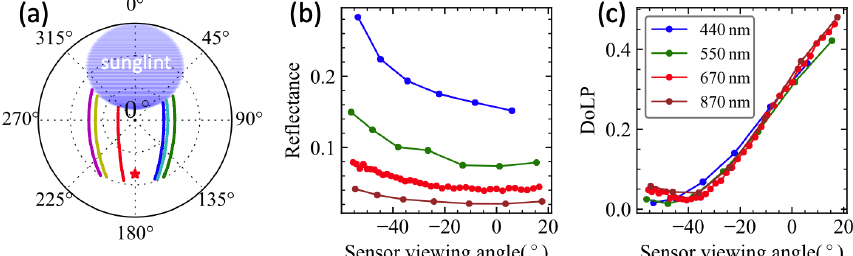
Figure 2. (a) Random viewing geometry with different examples indicated by different colors in the polar plot of zenith angles (radial direction) and azimuth angles. The red star symbol indicates the anti-solar direction at a zenith angle of 50 ◦ and azimuth angle of 180 ◦ . The blue oval shape indicates the sunglint region removed in this study. (b, c) Example synthetic HARP2 data with added random noise for reflectance and DoLP. The sensor viewing angle indicates the viewing zenith angle in the along-track direction, with a positive angle indicating forward-looking directions and a negative sign indicating the angle viewing backward (within the azimuthal angle between 90 and 270 ◦ ).